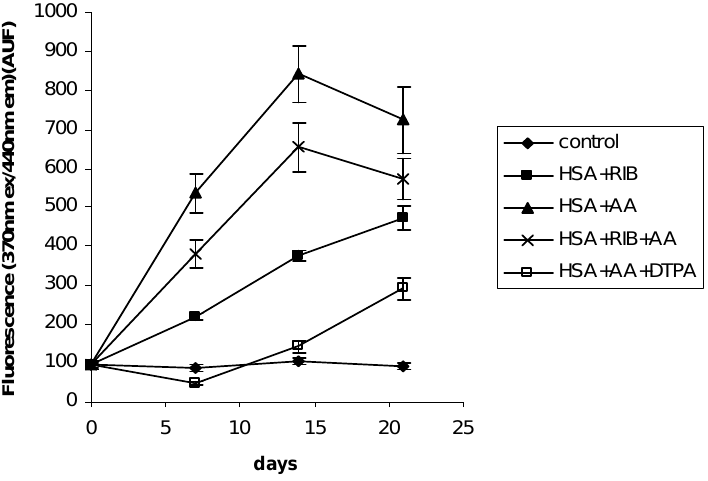
Figure 7. Effects of ribose, AA, ribose + AA, and AA + DTPA on 370/440 nm fluorescence of HSA during 21 days of incubation.